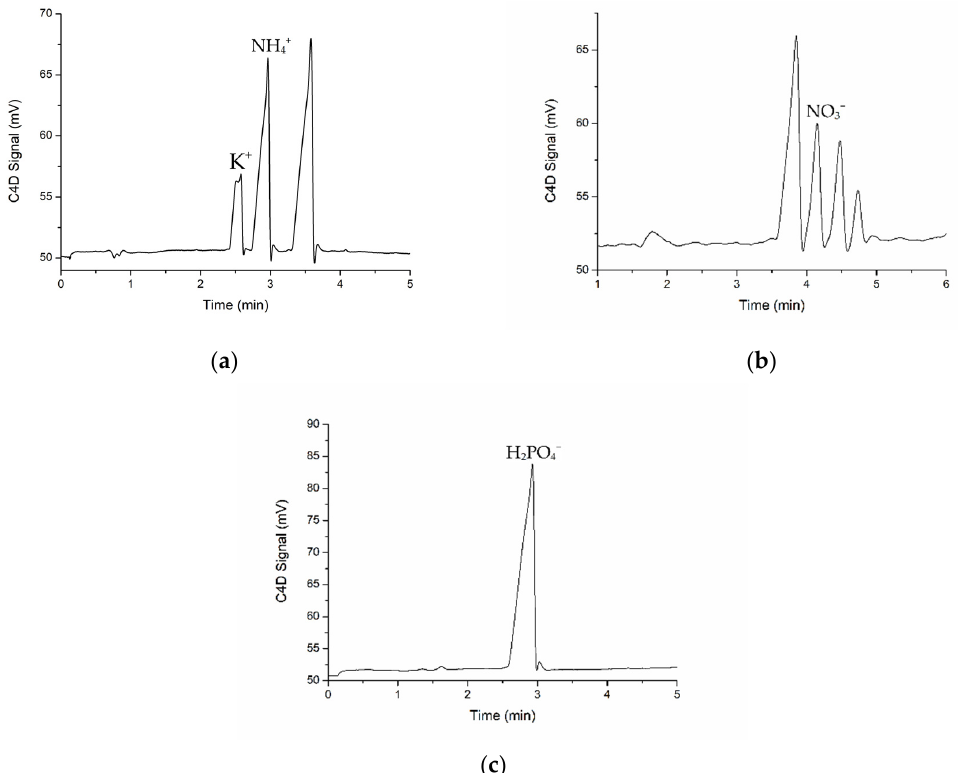
Figure 5. Electrophoretic electropherograms of a soil sample with peaks of ( a ) K + and NH 4+ , ( b ) NO 3 − and ( c ) H 2 PO 4 − with C4D detection. and ( c ) H 2 PO 4 − with C4D